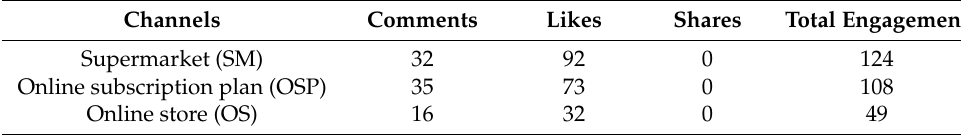
Table 2. Engagement with the